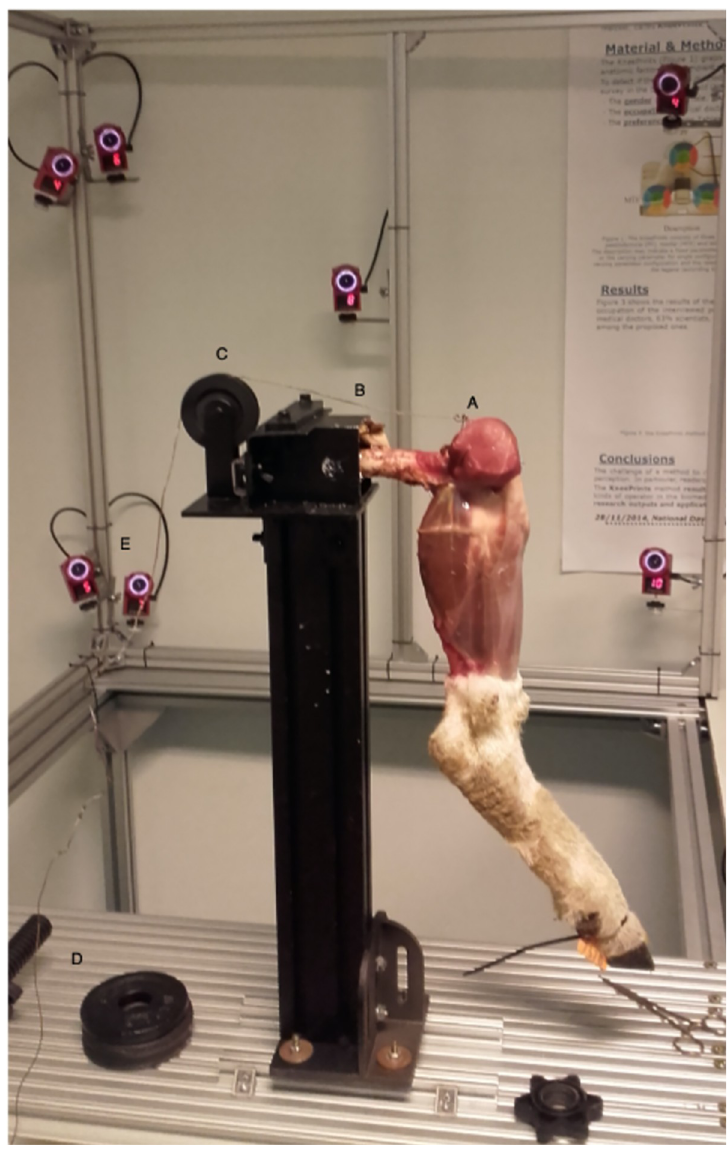
Fig 1. Biomechanical ex vivo sheep model of 3D joint mobility. The distal portion of the gastrocnemius and its tendon are tightened by a Colson ring (A). A metallic wire (B) is connected, via a pulley (C), to a metallic bar to which weight plates are loaded (D). The stereo-photogrammetric system (Optitrack) is composed of 10 cameras and 2 optical references frames (rigidly attached to the tibia and the femur) to record and measure the kinematics of a knee joint (E). induction of lesions since a prevalence study demonstrated that it was a site of naturally occur- ring cartilage defects in this population of research sheep [31]. To create chondral lesions on both (the left and right) limbs, the joint capsule was minimally incised on 5 cm medially to the patellar ligament, with the leg in flexion. Fat was removed to expose the medial condyle. Three 8 mm diameter chondral defects were created in situ by drilling the cartilage deep to the calci- fied layer using an 8 mm diameter biopsy punch to delineate the lesion and a Volkmann curette to remove the cartilage (Fig 3). The articular capsule was then closed with vicryl 2.0 in a continuous pattern. Flexion-extension cycles of the leg were recorded again (with increasing